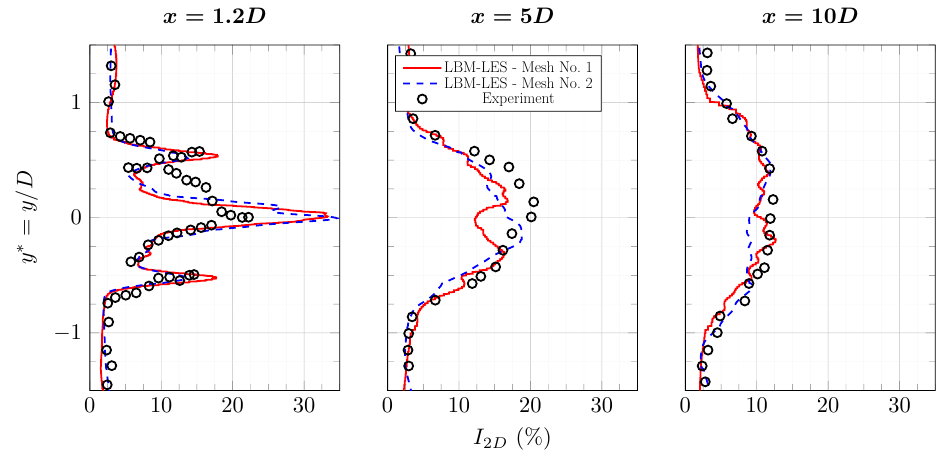
Figure 17. Average turbulence intensity profiles I 2 D in the wake of the tidal turbine at TSR = 3.67 and I = 3%. Results are from experiment [6] and from LBM-LES simulations with mesh Nos. 1 and 2. The complete set of profiles is in Appendix A.